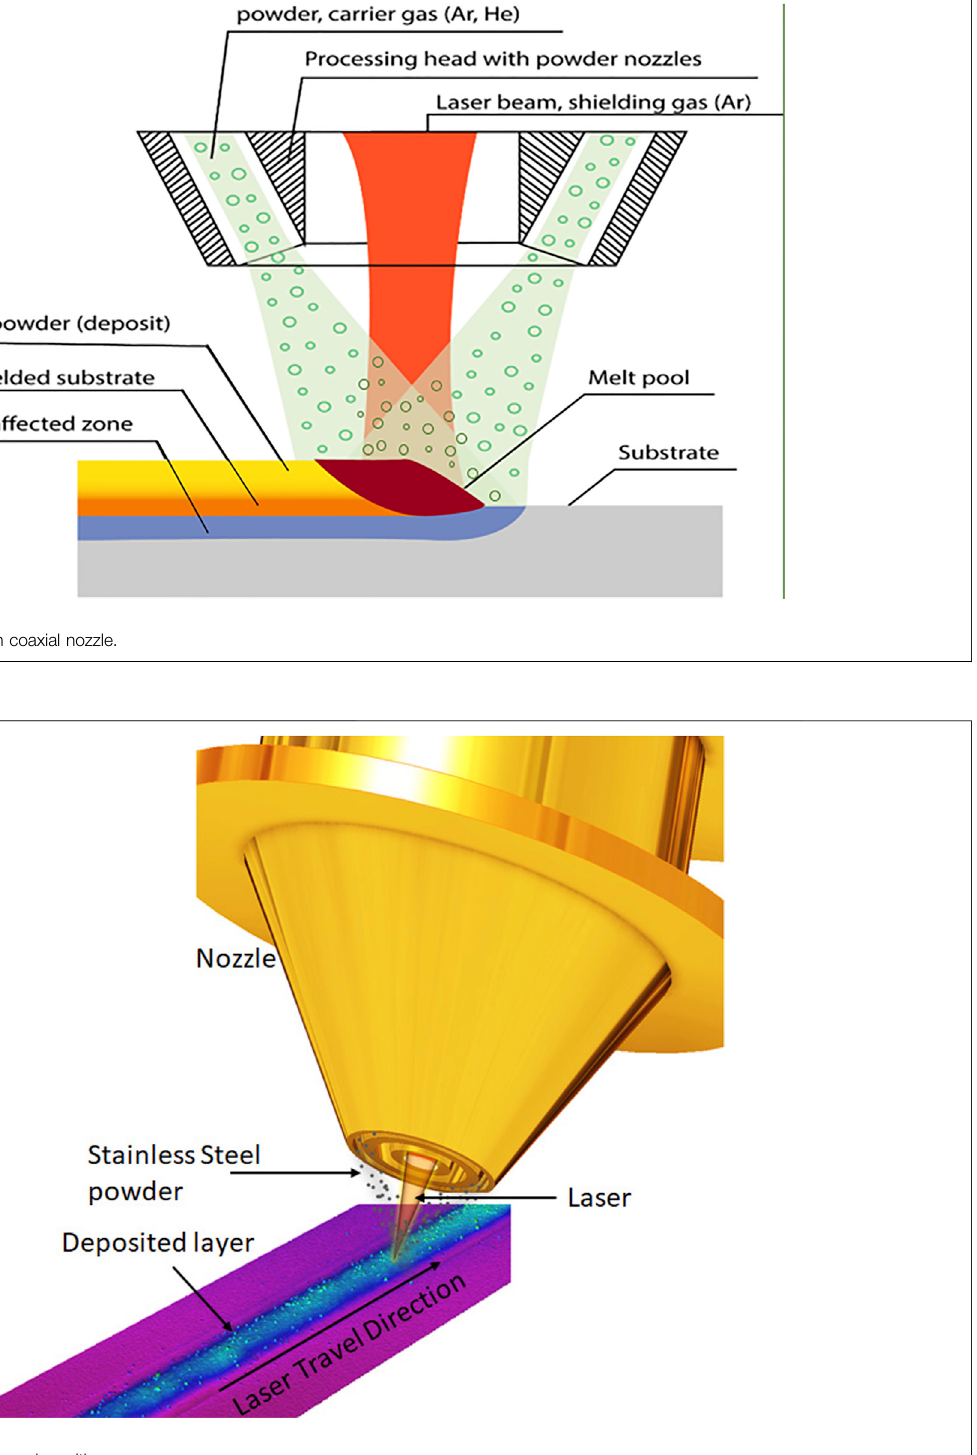
Frontiers in Mechanical Engineering |